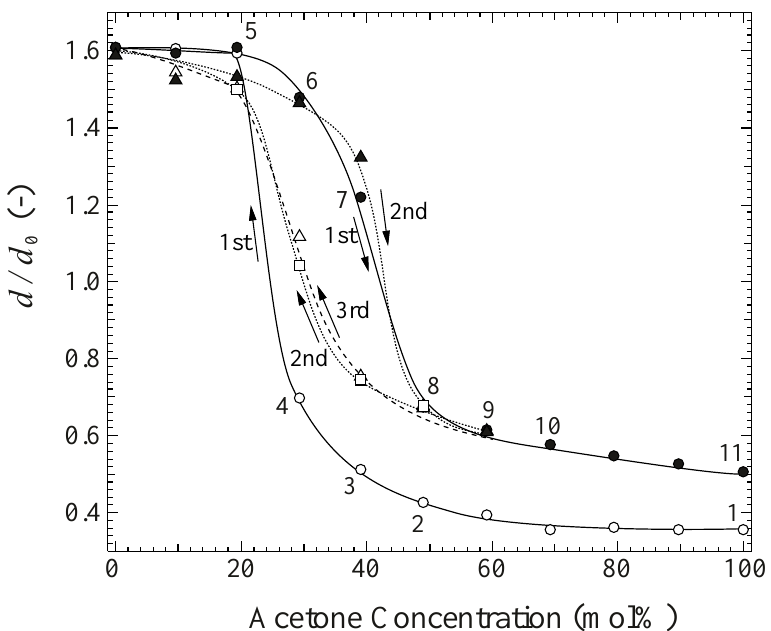
Figure 3. Swelling ratio of chemically crosslinked and dehydrated gels in a DMSO/acetone mixed solvent obtained by a single-sample test. The measurement was initiated from the collapsed state in acetone, and the concentration was successively changed relative to DMSO and acetone.